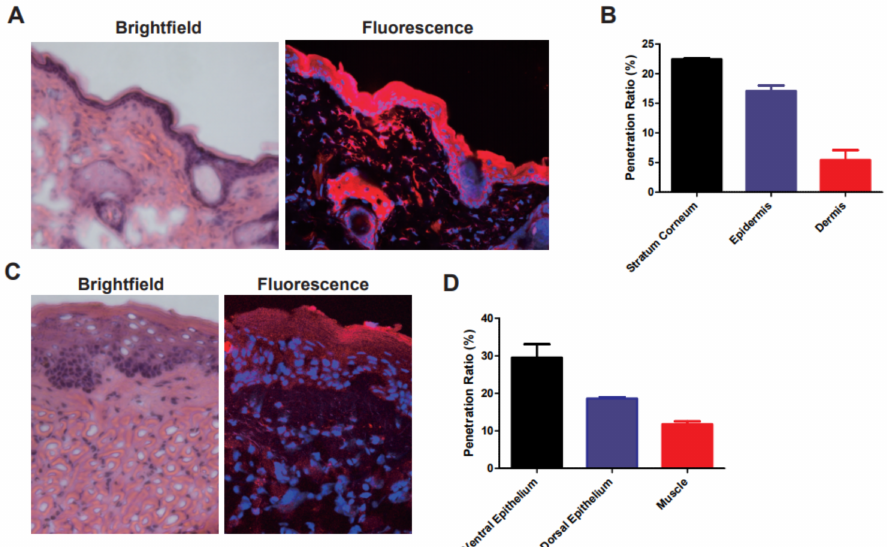
Figure 5. ( A ) The histological analysis (H&E staining, left) and fluorescence image (right) of skin acquired by confocal microscopy after topical application of Cy5.5-labeled HA nanogels, and ( B ) the penetration ratio of Cy5.5-labeled HA nanogels in each layer of skin. ( C ) The histological analysis and ( D ) penetration ratio for underside of